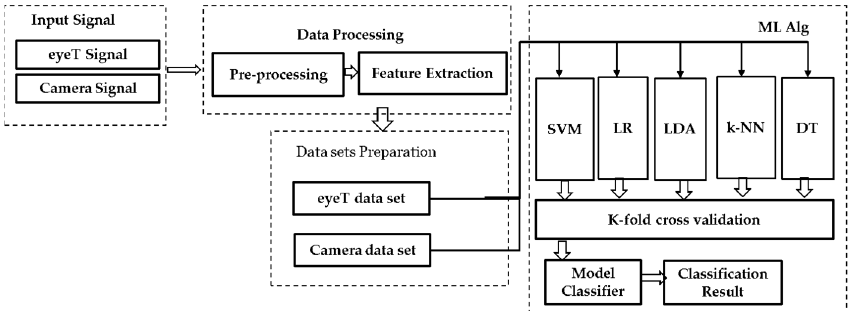
Figure 4. Overview of cognitive load classification machine learning approach: (1) input signal, (2) data processing, (3) data sets preparation, (4) model classifiers, and classification results.